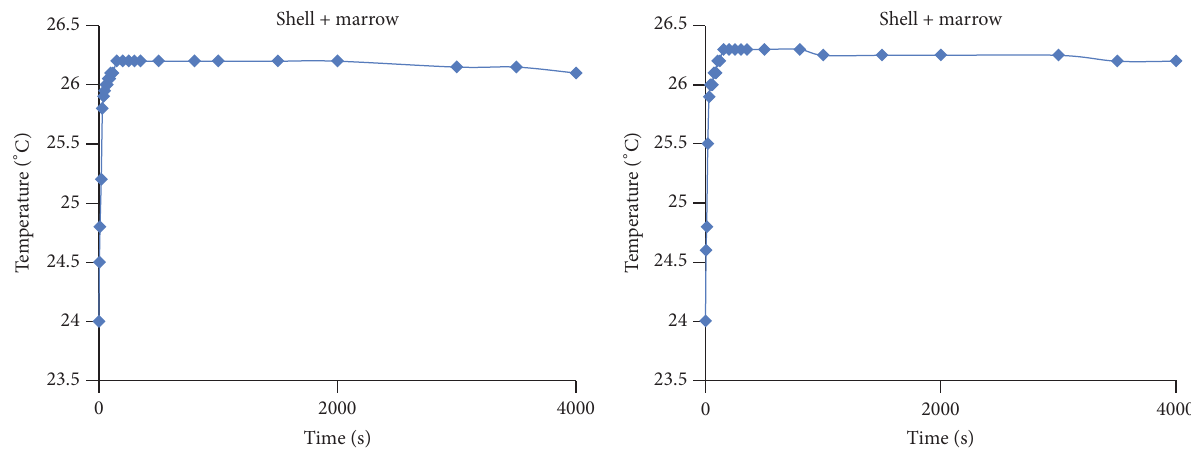
Figure 7: Variation of the water temperature of the calorimeter after the introduction of hot bamboo.